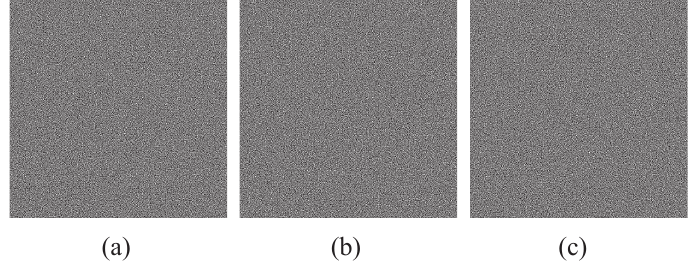
Figure 10. Noise-like shadows of the proposed ( 3,3 ) -SDIS: ( a ) NS 1 ( b ) NS 2 ( c ) NS 3 . Experiment B. Three binary meaningful shadows BS 1 − BS 3 of the proposed ( 3, 3 ) -SDIS sharing a 256-color secret image are demonstrated.